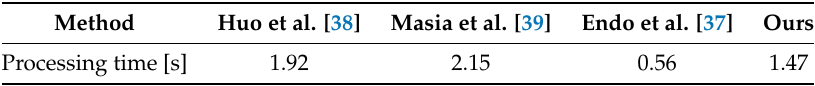
Figure 15. The test images and results using the proposed technique, ( a – c ) and ( g – i ) are the input images [41], ( d – f ) and ( j – l ) are the output images with tone-mapping. Table 3. The processing time of the proposed technique and other